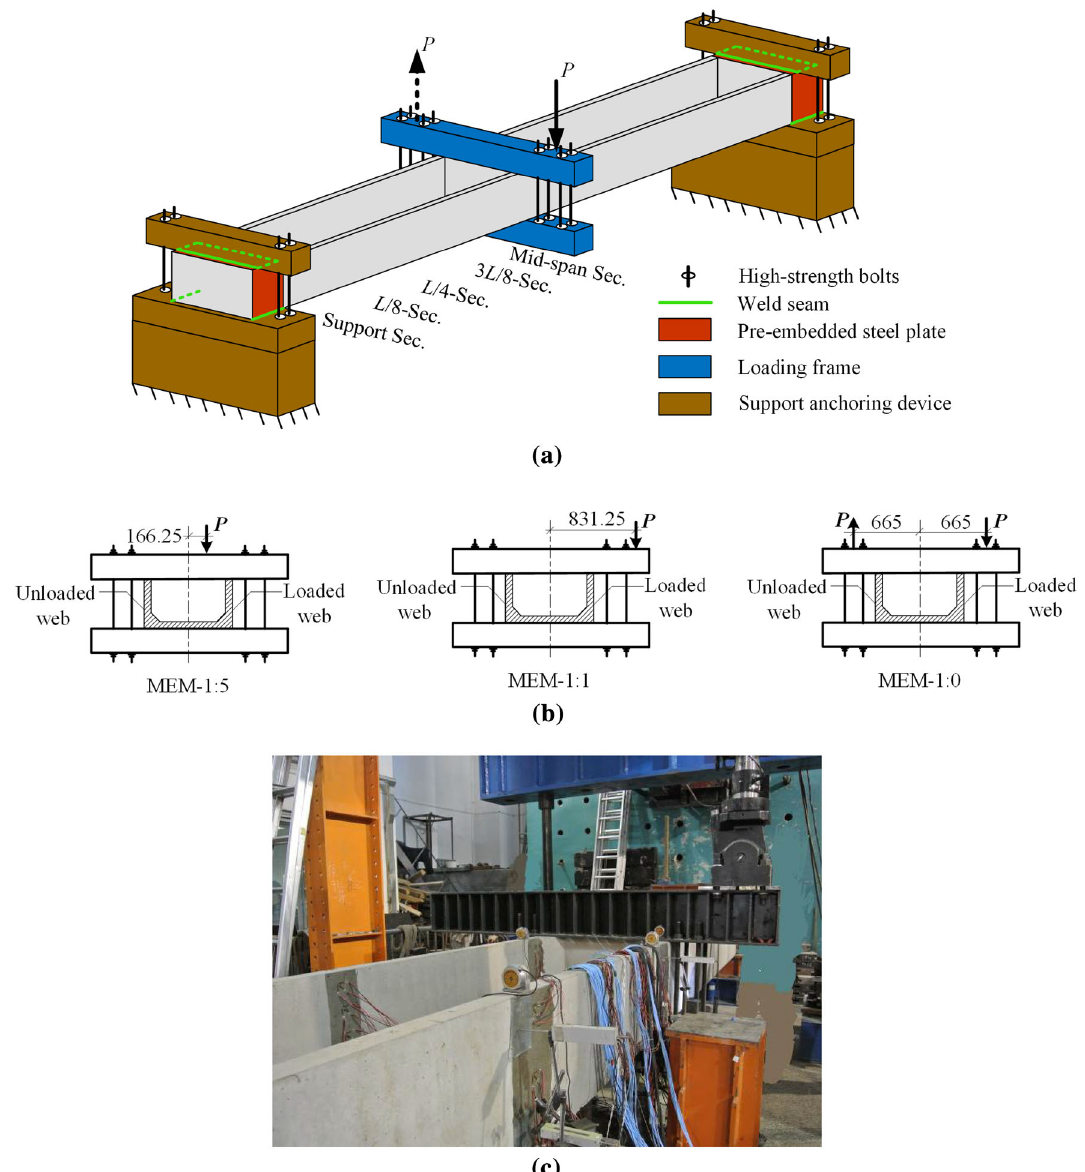
Fig. 2 Testing setup of U-shaped thin-walled beams (unit: mm). a Schematic diagram of testing setup, b loading information of test, specimens, and c loading condition of